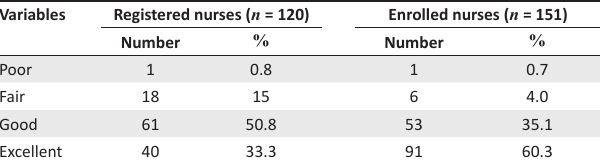
TABLE 3: In general, how would you describe the quality of nursing care delivered to patients on your